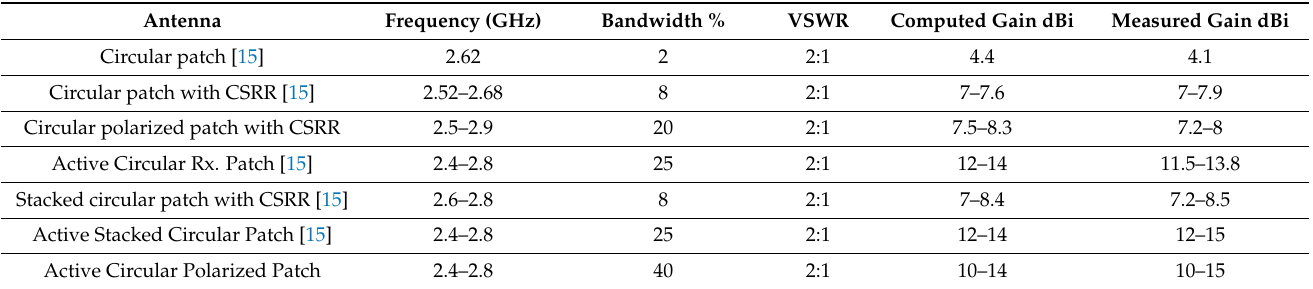
Figure 12. Gain , S21, of the Circular Polarized Active Receiving Sensor. Figure 12. Gain, S21, of the Circular Polarized Active Receiving Sensor.